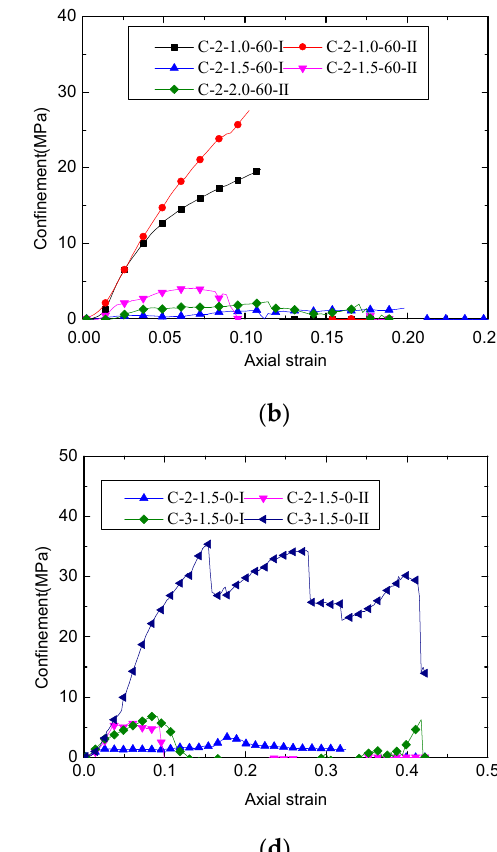
Figure 13. Relationship between the confining pressure–axial strain curve of CSBM specimens: ( a ) Series 1; ( b ) Series 2; ( c ) Series 3; ( d ) Series 4. The confining pressure provided by the exterior CFRP tube is theoretically calculated by substituting the hoop strain in Figure 11 into Equation (1).